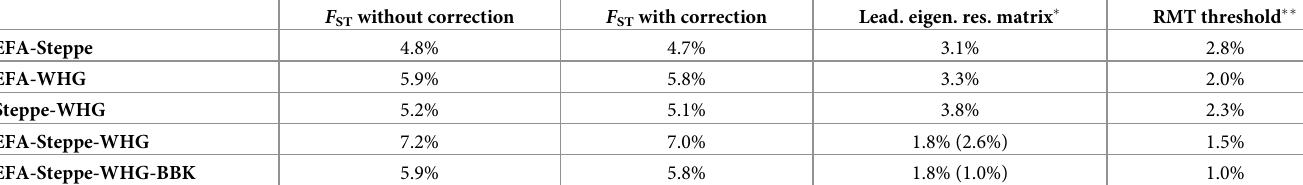
Table 2. F ST estimates for ancient Eurasian samples with correction for genomic coverage. F ST without correction F ST with correction Lead. eigen. res. matrix � RMT threshold